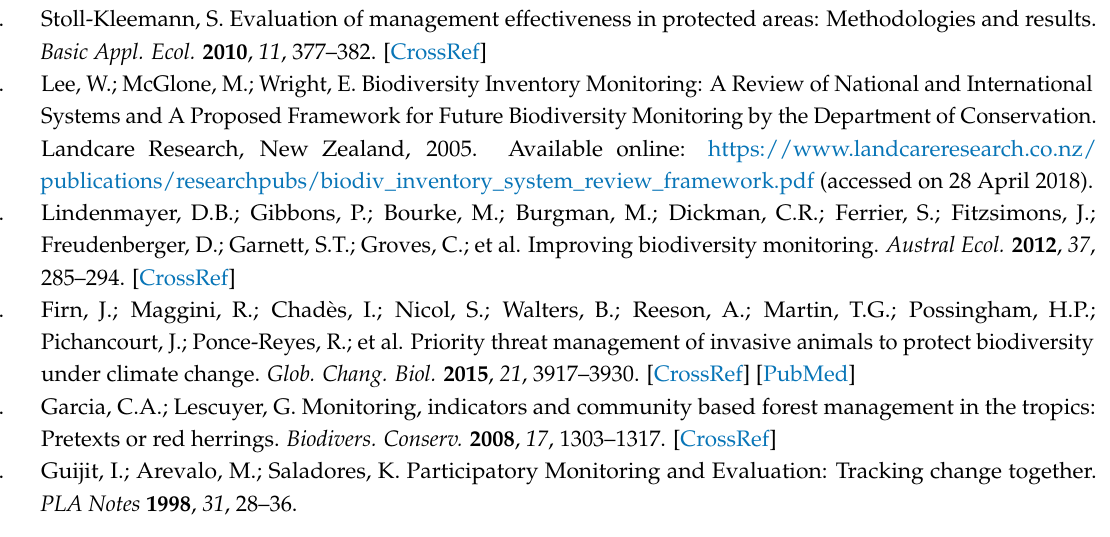
Table S1: Interview questionnaire